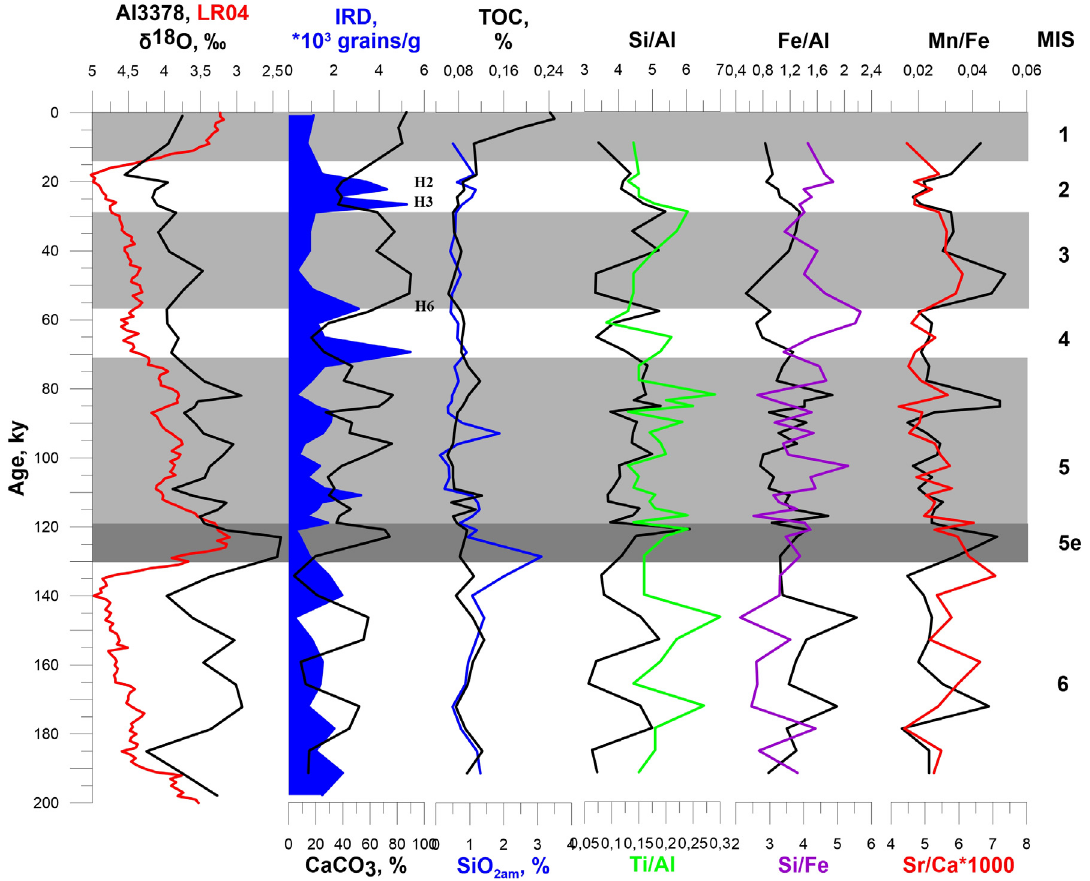
Figure 3. Stable oxygen isotope ratios (‰) in planktonic foraminiferal tests; LR 04_ ‐ standard curve [38], ice ‐ rafted debris (IRD, 10 3 grains/g); CaCO 3 (%); TOC (C org )%; SiO 2am (%); and elemental ratios Si/Al, Ti/Al, Fe/Al, Si/Fe, Mn/Fe, and (Sr/Ca)1000 in AI ‐ 3378 sediment core (the Snorri Drift). Colored fill indicates the interglacial stages. H2 H3, and H6 are the Heinrich events.